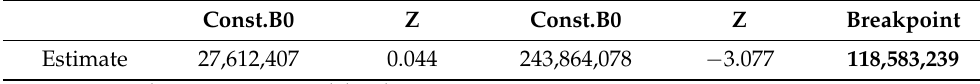
Table 1. Model of piecewise linear regression between Pc and Z (N = 2570). Const.B0 Z Const.B0 Z Breakpoint Estimate 27,612,407 0.044 243,864,078 − 3.077